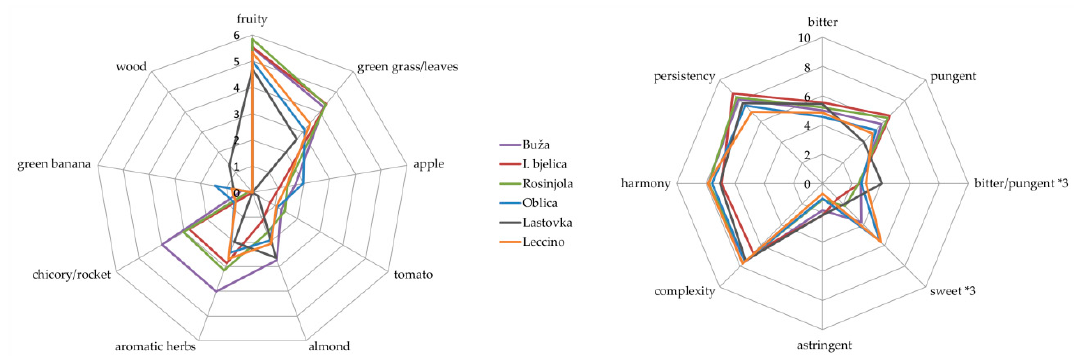
Figure 3. The intensities of the sensory attributes obtained by quantitative descriptive sensory analysis of monovarietal extra virgin olive oils (EVOOs) produced from Buža, Istarska bjelica, Rosinjola, Oblica, Lastovka, and Leccino varieties in Croatia (* 3 – the intensities of particular sensory attributes were multiplied by 3 to better visualize the differences between monovarietal EVOOs).